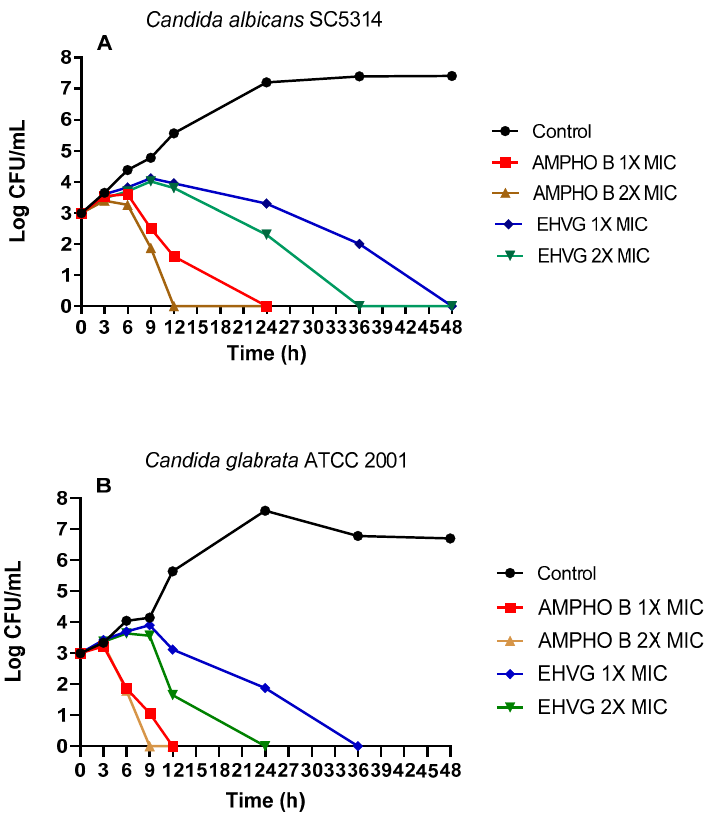
Figure 6. Effects of EHVG on time-kill curves. The effects of EHVG against Candida albicans SC5314 ( A ) and Candida glabrata ATCC 2001 ( B ) were tested at two different concentrations corresponding to the MIC or 2 × MIC, then compared to untreated cultures (Control) or with cultures treated with Amphotericin B (AMPHO B; MIC—0.5 µg/mL and 2× MIC—1 µg/mL).